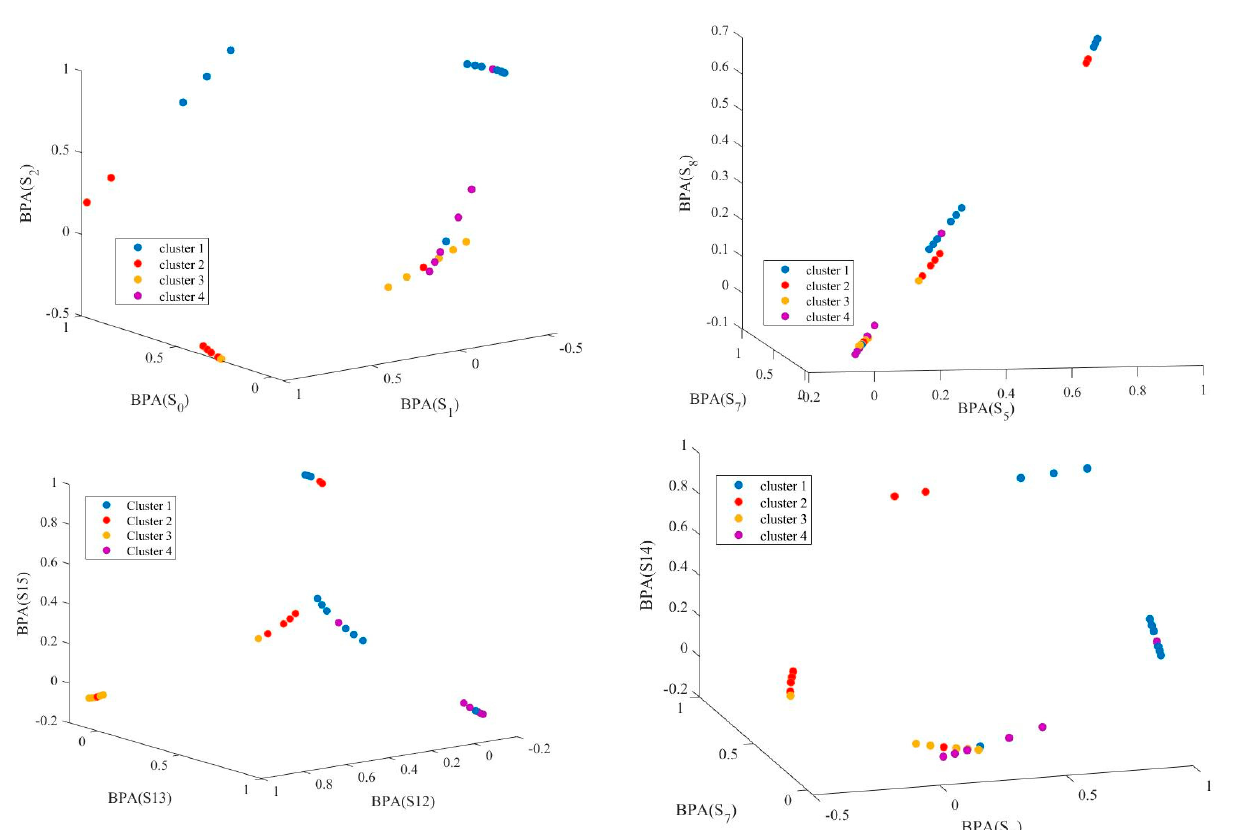
Figure 7. Analog circuit diagnostic tree potential ELM model accuracy comparison.